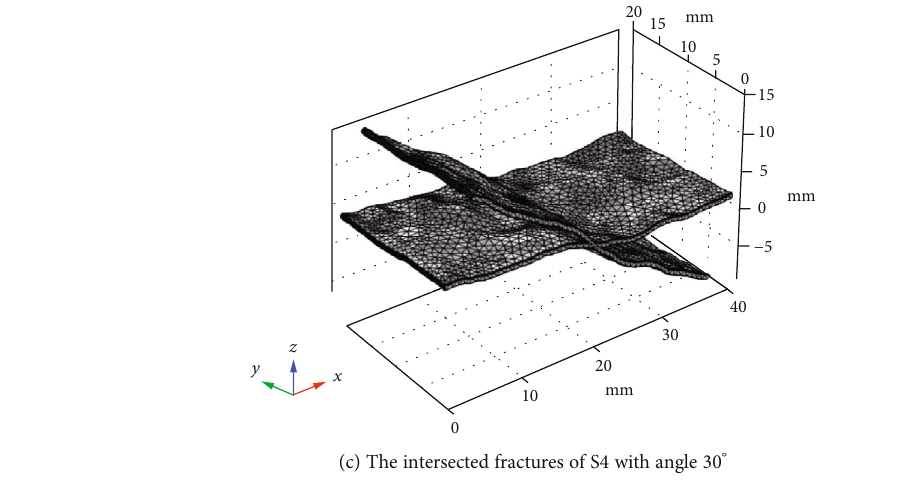
Figure 19: The intersection of rough fractures.